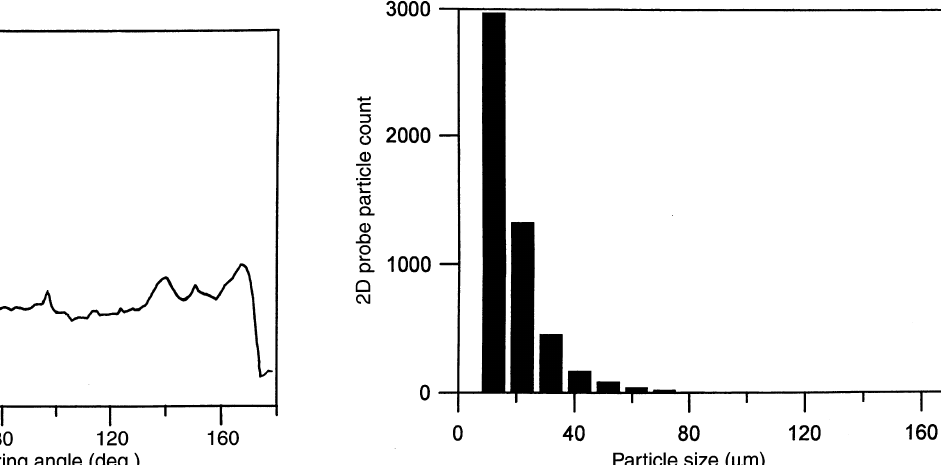
Fig. 9. Scattered intensity for the first 30-s interval of Fig. 8